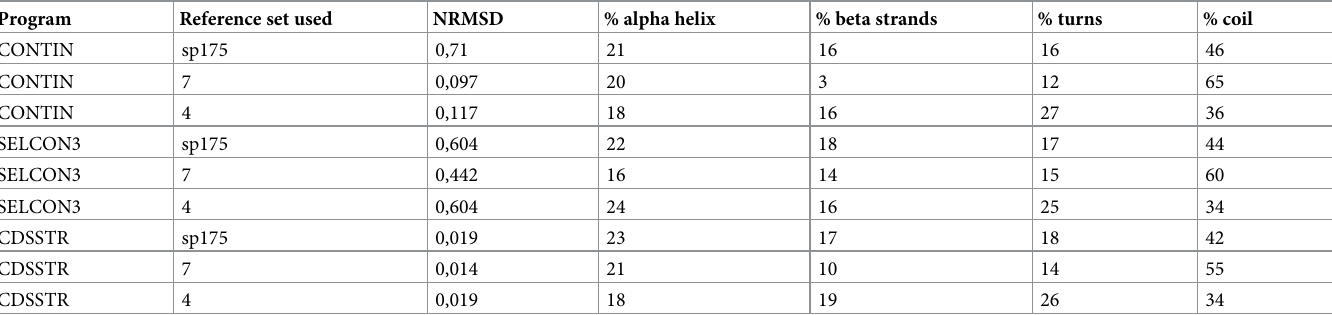
software are shown in Fig 6. It was predicted that the RBBP6-p53BD consists predominantly of random coil, with alpha-helical and beta-strand structures varying from model to model (Fig 6). The confidence of each model is measured using the c-score and is shown on each model in Fig 6. The c-score is generated based on the significance of the treading template alignment and convergence of parameters of the structure assembly simulations. The accept- able range for a c-score is -5 to 2, with a higher score signifying a model with higher confi- dence; however, a score greater than -1.5 indicates a model of correct global topology [38]. Global accuracy prediction is done using c-score and protein length for model 1 by I-TASSER and consists of a TM-Score and RMSD value. For model 1 the estimated TM-score was 0.65 ± 0.13, and the estimated RMSD was found to be 10.9 ± 4.6 Å . A TM-score is found to be between 0 and 1, with a TM greater than 0.5 indicating a model of correct topology. Models 2 and 3 generally have lower TM scores compared to model 1 and therefore aren’t reported by I-TASSER. Therefore, based on I-TASSER’s parameters, Model 1, is the most likely model for the RBBP6-p53BD. A secondary structure server, namely 2Struc [39] predicted the percentage of alpha-helices and beta-strands for the RBBP6-p53BD models generated by I-TASSER, using the protein data bank files generated by I-TASSER (Table 3). Percentages of alpha-helices, beta-strands, and Table 2. DICHROWEB secondary structure